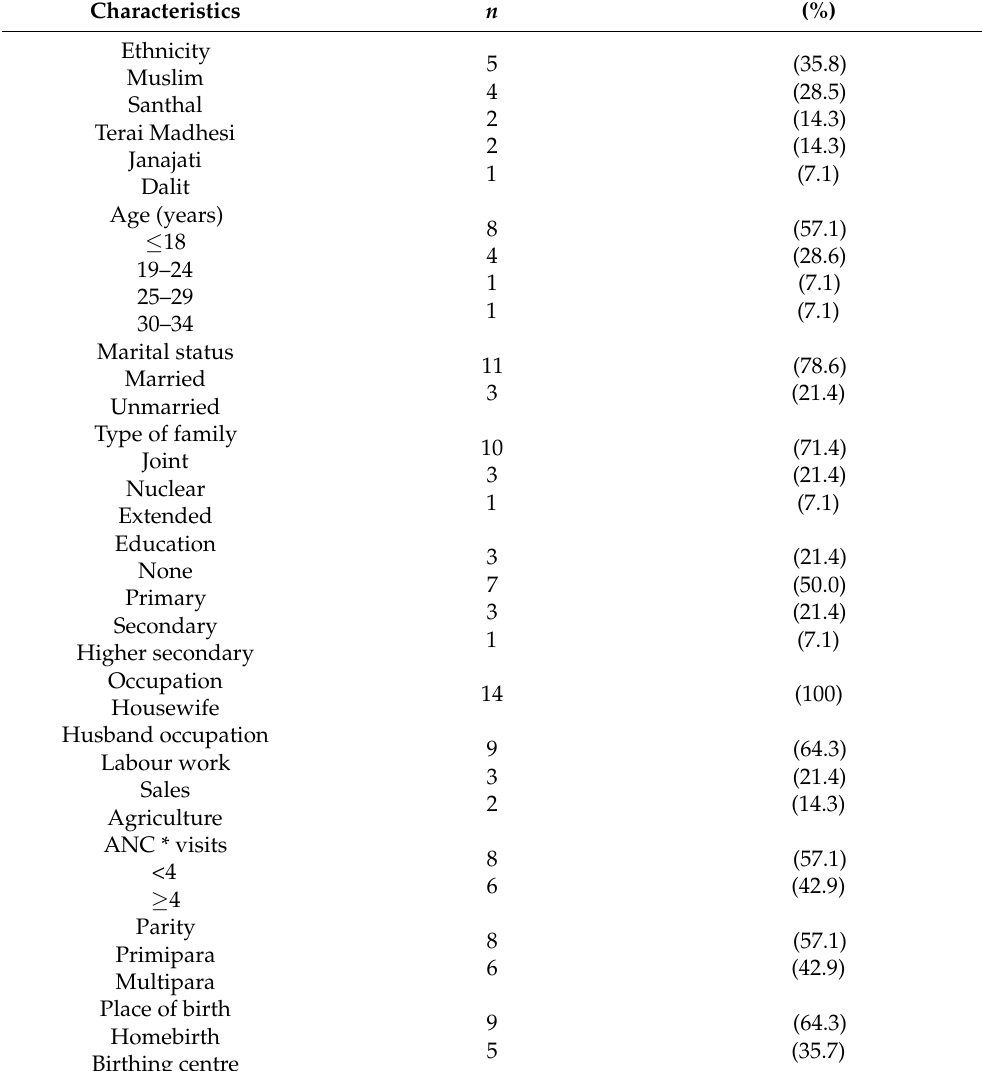
Table 1. Background characteristics of the participants ( n =